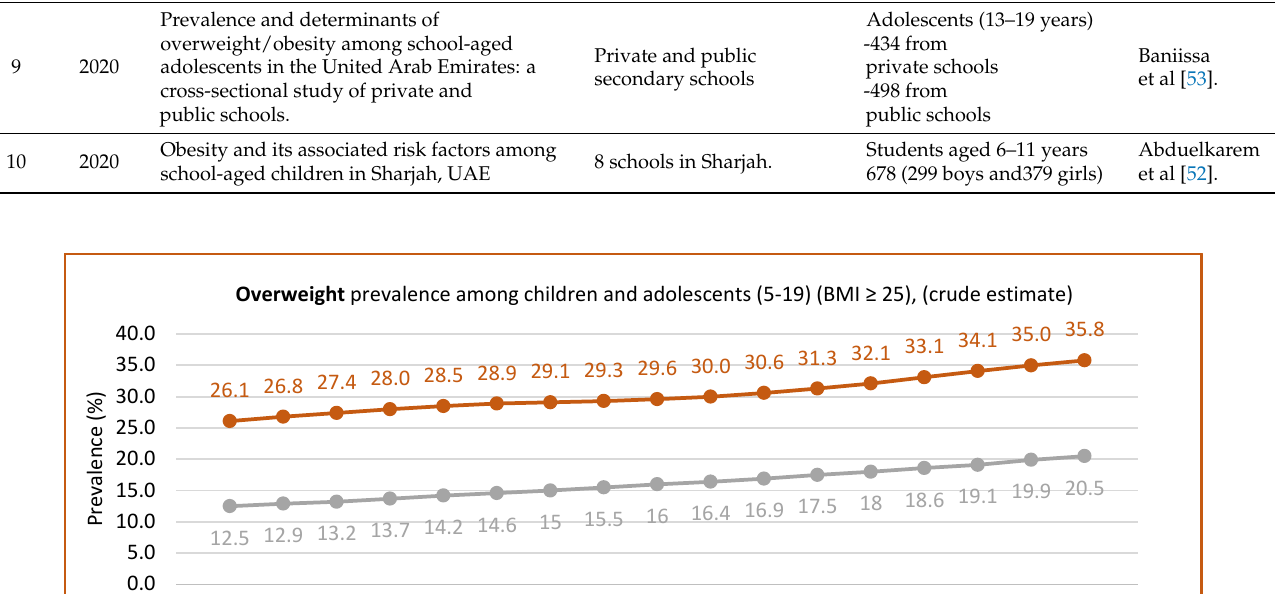
Figure 4. Obesity prevalence in children and adolescents (aged 5 – 19 years) (BMI ≥ 30) (crude esti- mate). Source: https://www.who.int/data/gho/data.http://www.healthdata.org/results/country-pro- file (accessed on 5 December 2022) [33,35]. 3.3.2. Adults Limited studies have been conducted in the UAE regarding the nutritional status of adults in the past decade. A total of 23 articles were extracted, reporting data on obesity and overweight in adults (Table 3) . These studies primarily reported data on the preva- lence rates, the risk factors, and the effects of obesity. A systematic review by Radwan et al. [59] reported high prevalence rates of obesity, diabetes, hypertension, and metabolic syndrome in all studies. Similar findings were reported in other studies as well. Razzak et al. [60], in their cross-sectional study, found that the prevalence of obesity was higher in proportion among adult females than in adult males in UAE. Extensive evidence points to the role of obesity in the development of several chronic diseases. Sulaiman et al. [61] conducted a study of 3064 expatriates in the UAE. Their find- ings revealed a high prevalence of overweight and obesity in the sample. In addition, the prevalence rates for chronic disorders, such as diabetes, hypertension, and hypercholes- terolemia, were 15.5%, 31.8%, and 51.7%, respectively, with each disorder being higher in those people with obesity. Another study, conducted on students at Ajman University, observed a correlation between high BMI and prehypertension, as well as high glucose levels and other risk factors such as smoking and a sedentary lifestyle [62]. Shah and his